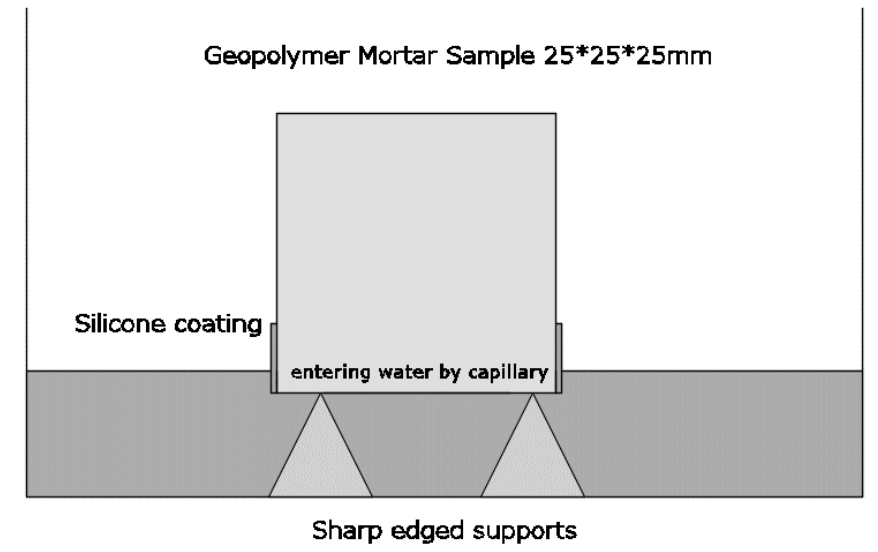
Fig. 5. Water sorptivity test for geopolymer